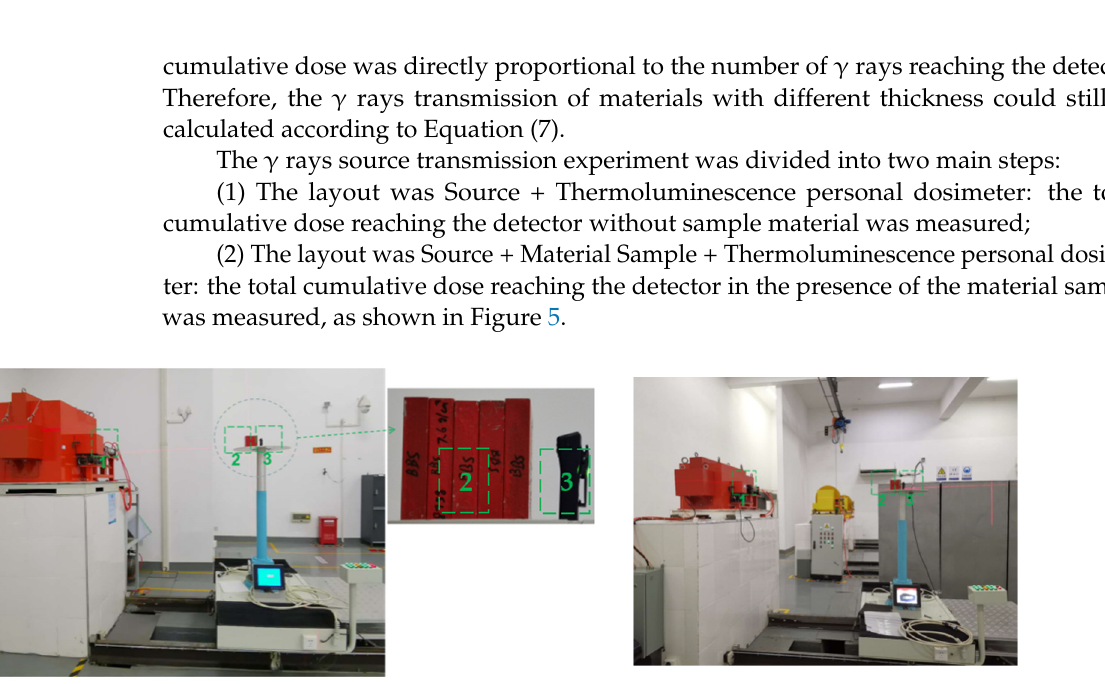
factors are shown in Table 4.